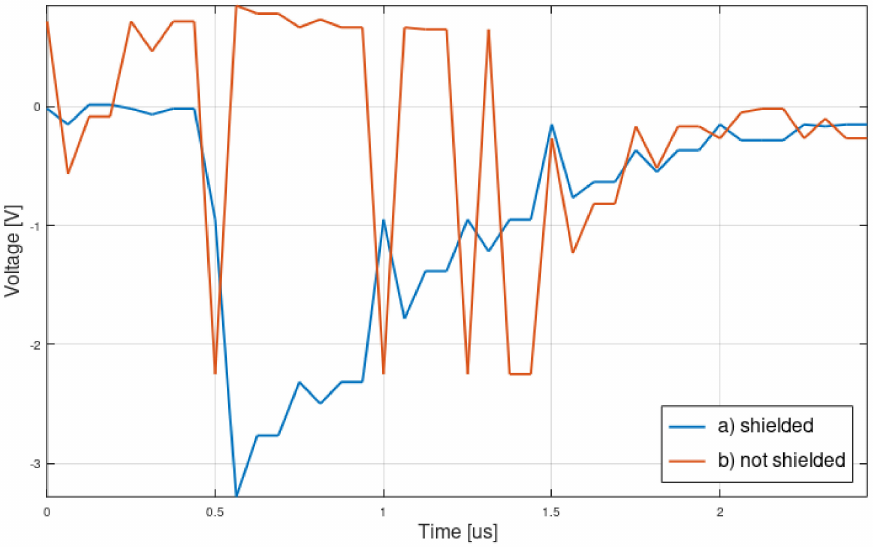
Figure 8. Pulse recorded with and without a shielded device for the maximum sampling rate.